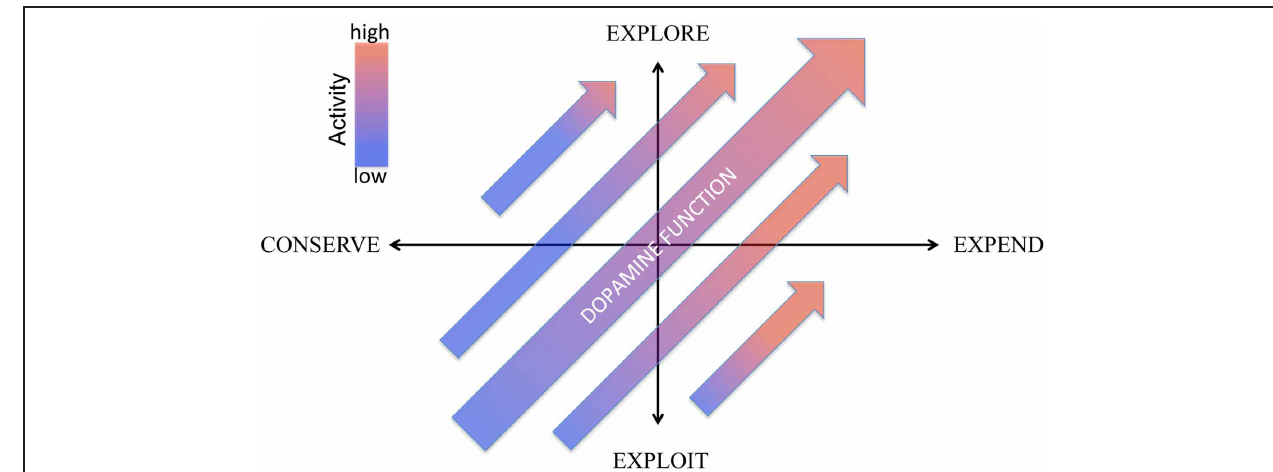
FIGURE 1 | Two axes conceptual framework for regulation of behavioral energy expenditure by dopamine. The horizontal axes represents dopamine’s role in regulating generalized activity levels along a continuum from low activity (conserve) to high activity (expend). The vertical axes represent the role of dopamine in regulating the balance between exploration and exploitation by modulating the degree to which reward information biases the distribution of behavioral activity. “Dopamine function” is construed broadly here and may include not only extracellular concentrations of dopamine in target regions, activity of dopamine neurons (i.e., rate of tonic activity, prevalence of bursting) but also parameters such as relative expression of different